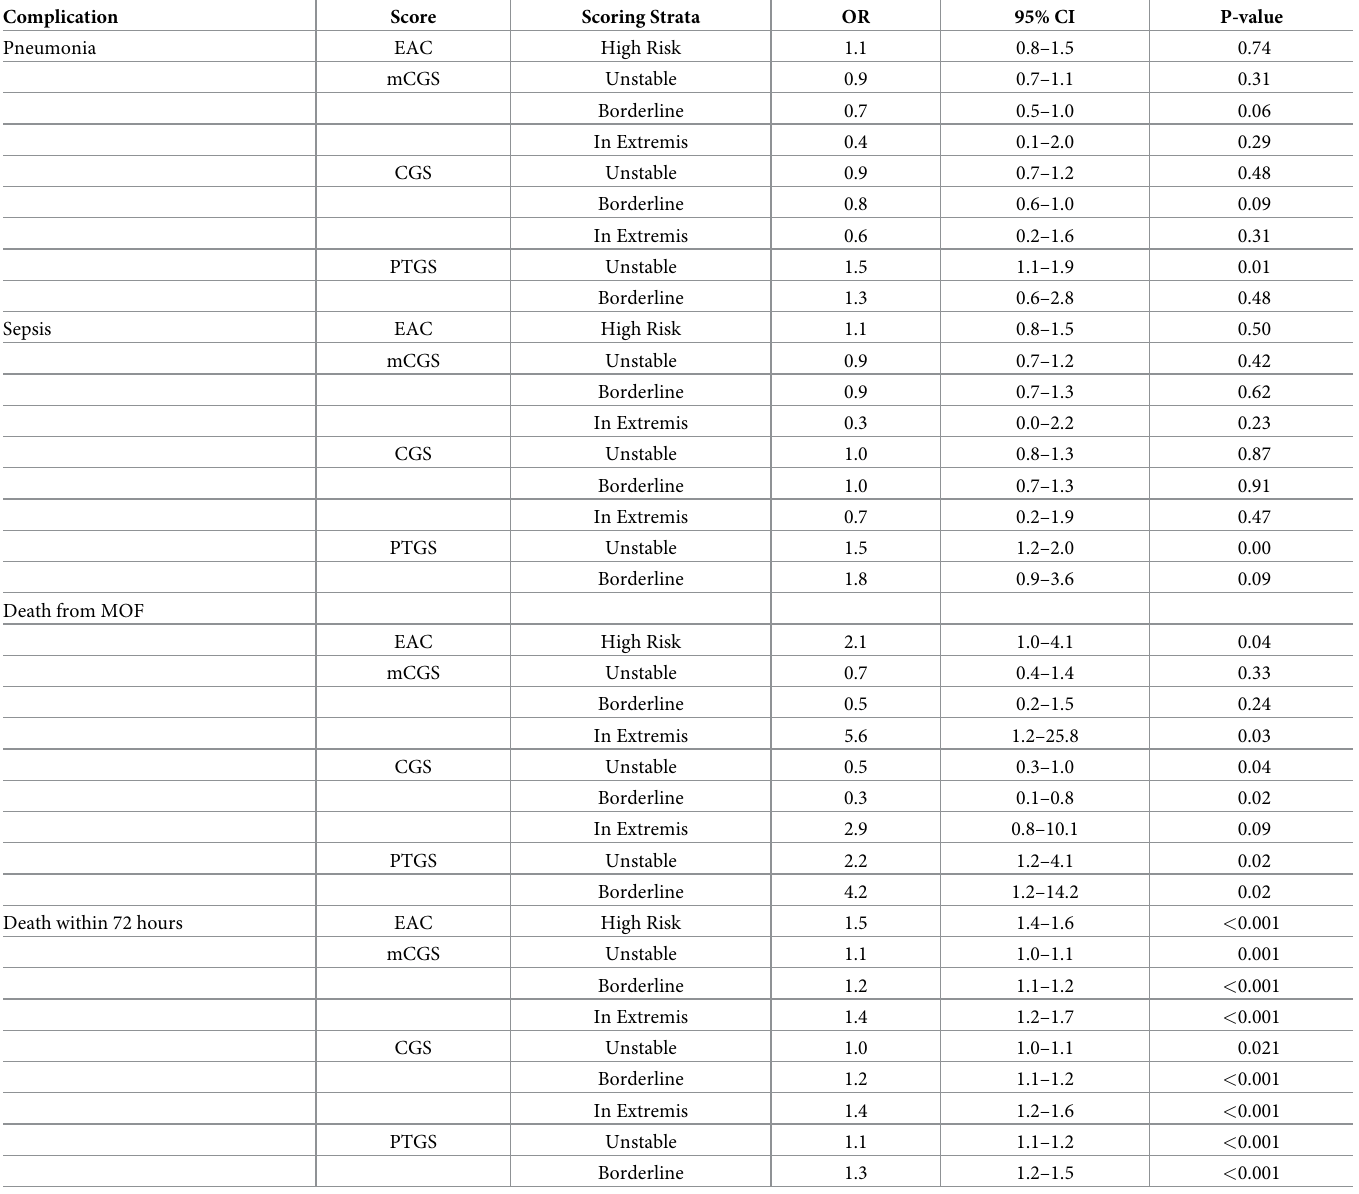
Table 2. Predictive capability of each score individually compared to the lowest scoring